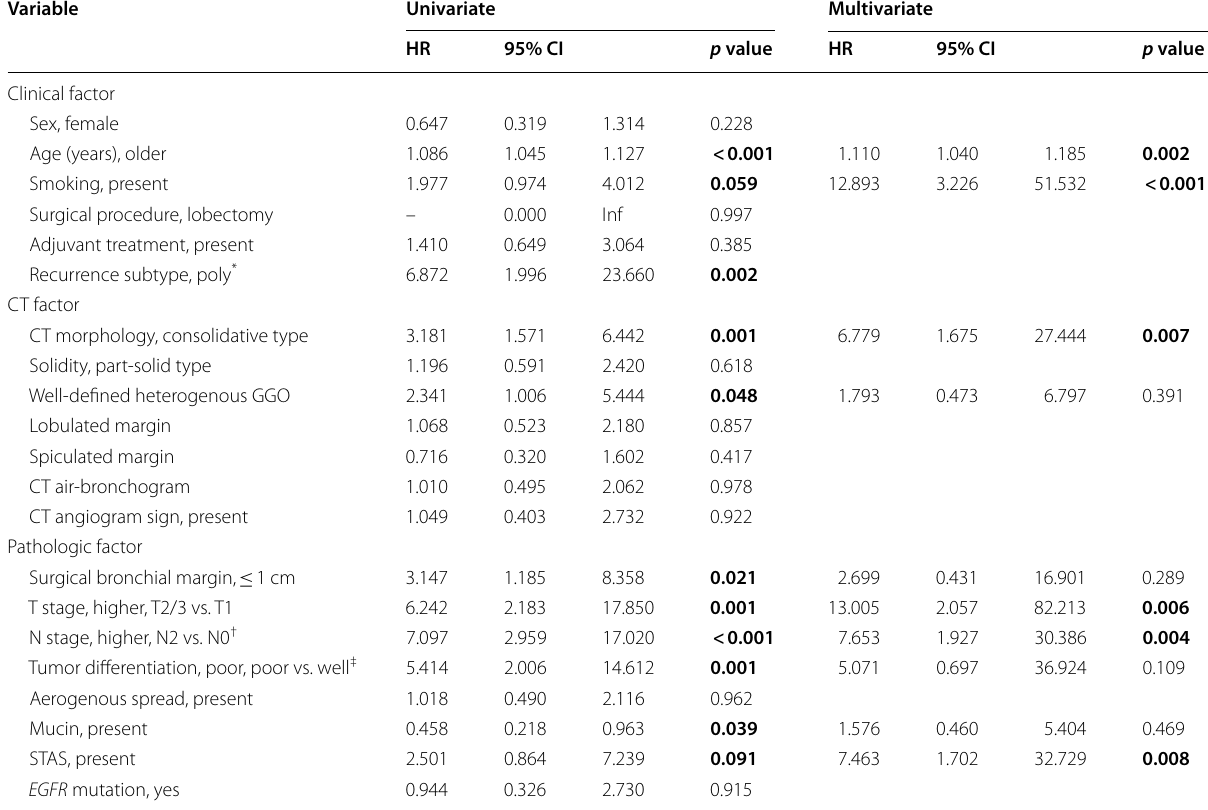
Table 4 Results of univariate and multivariate analyses of overall